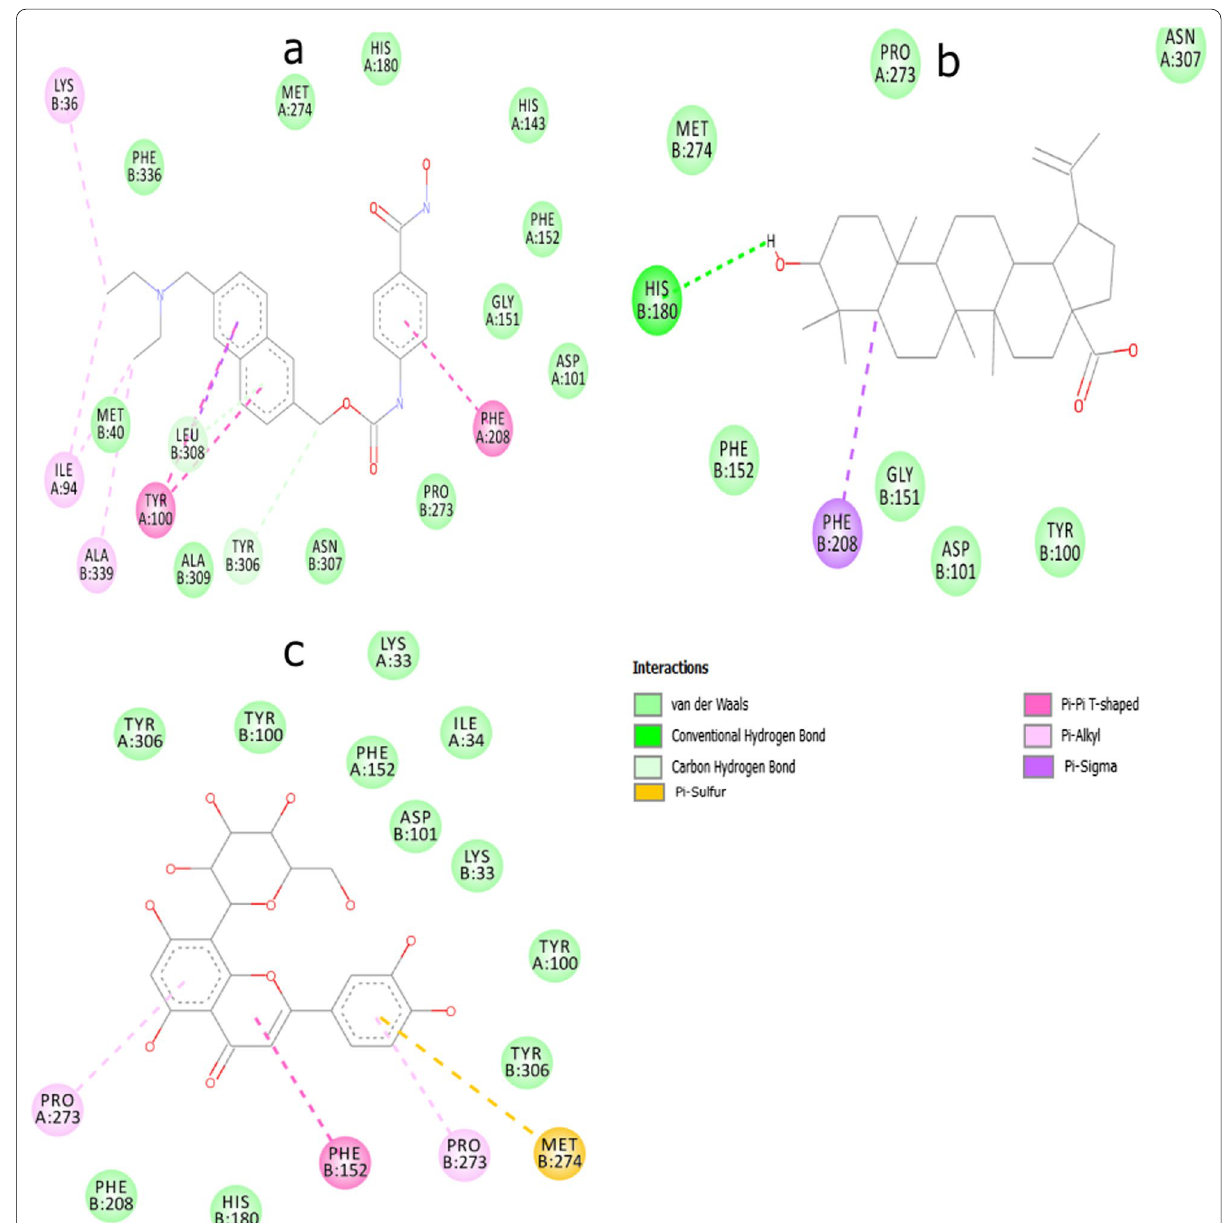
Fig. 6 2D view of the interaction between a givinostat b betulinic acid c orientin and amino acids in the binding sites in histone deacetylase